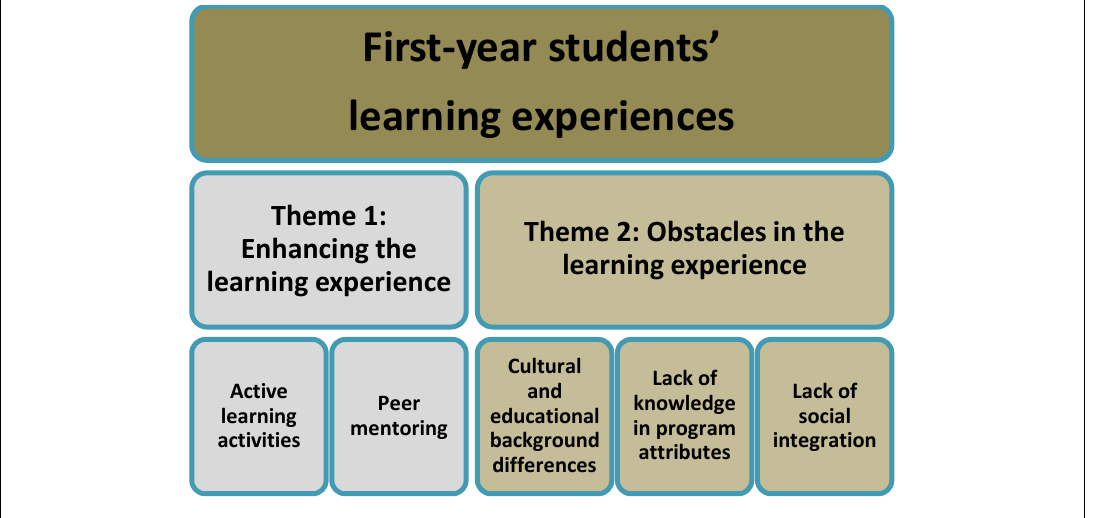
Figure 3. The conceptual framework for first- year students’ learning